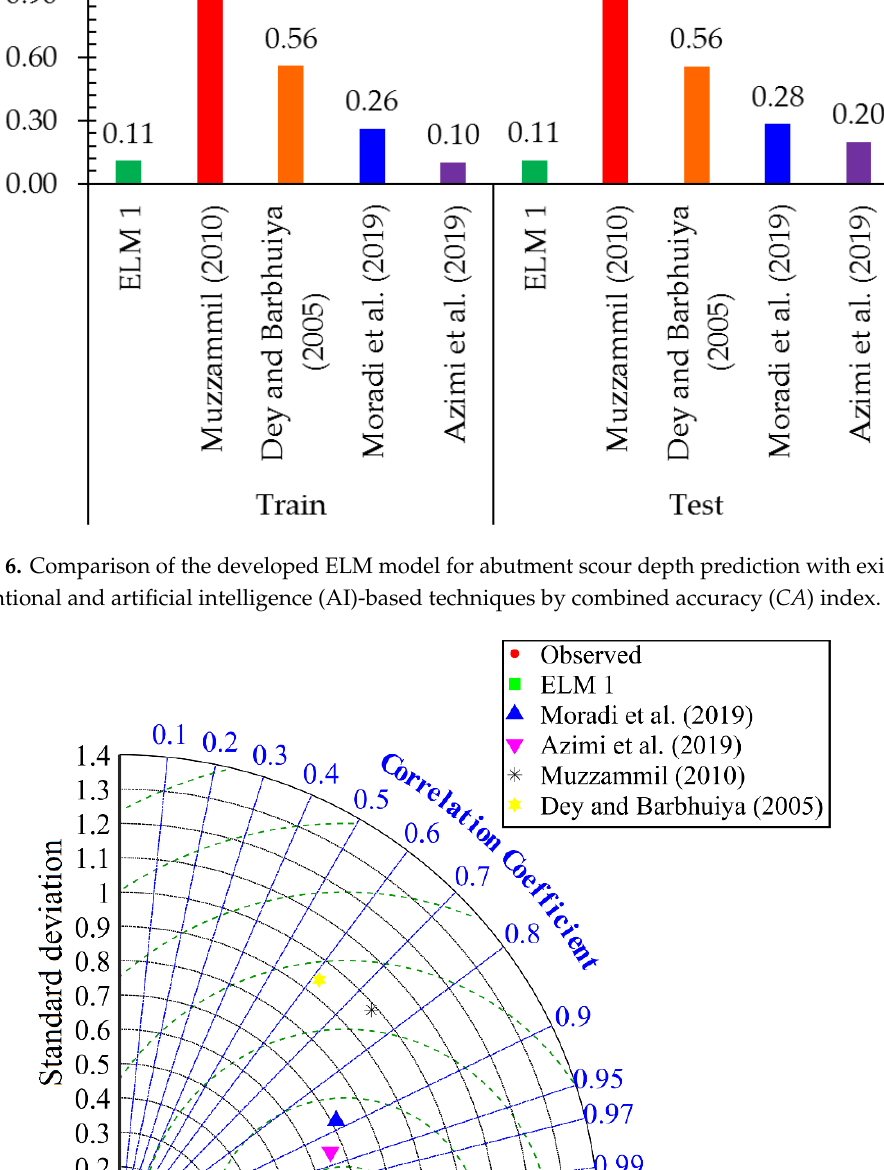
Figure 7. Taylor diagram for developed ELM model and conventional regression-based and Figure 8. Taylor diagram for developed ELM model and conventional regression-based and AI-based AI-based techniques.